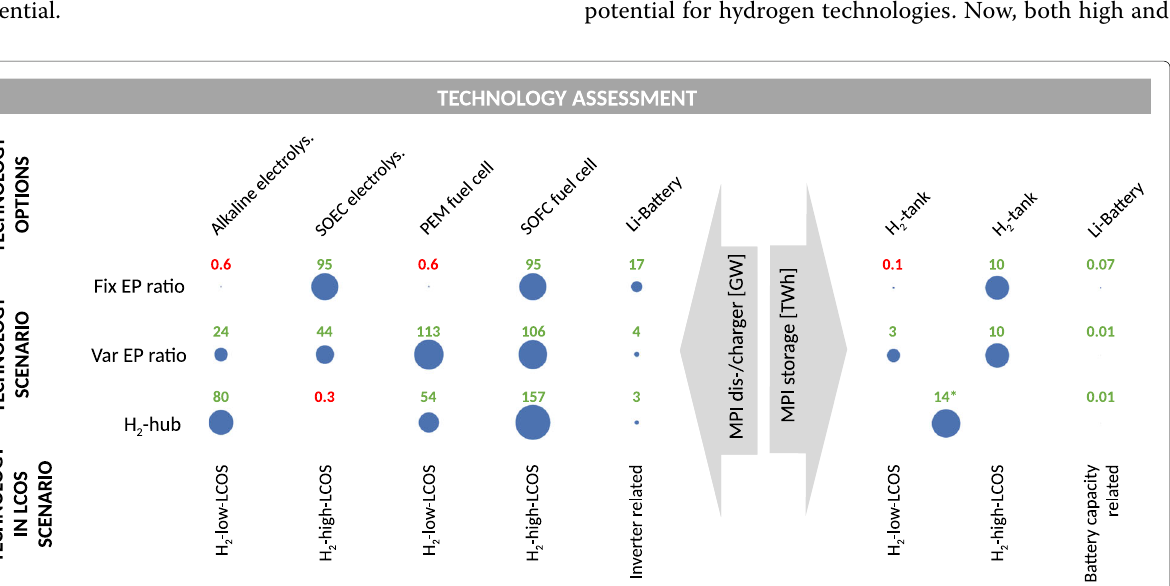
Fig. 9 Market potential indicator for all charging and discharging components in Europe for three technical storage scenarios in a zero emission electricity system. Despite having the same economic and technical input data the market potential vary drastically between the scenarios. The SOFC fuel cell and Li-battery are according to the market potential method, the technologies which are most likely to be valuable in the exemplary set of scenarios. Because they have an optimised market potential indicator in each scenario. *Refers to the total shared storage